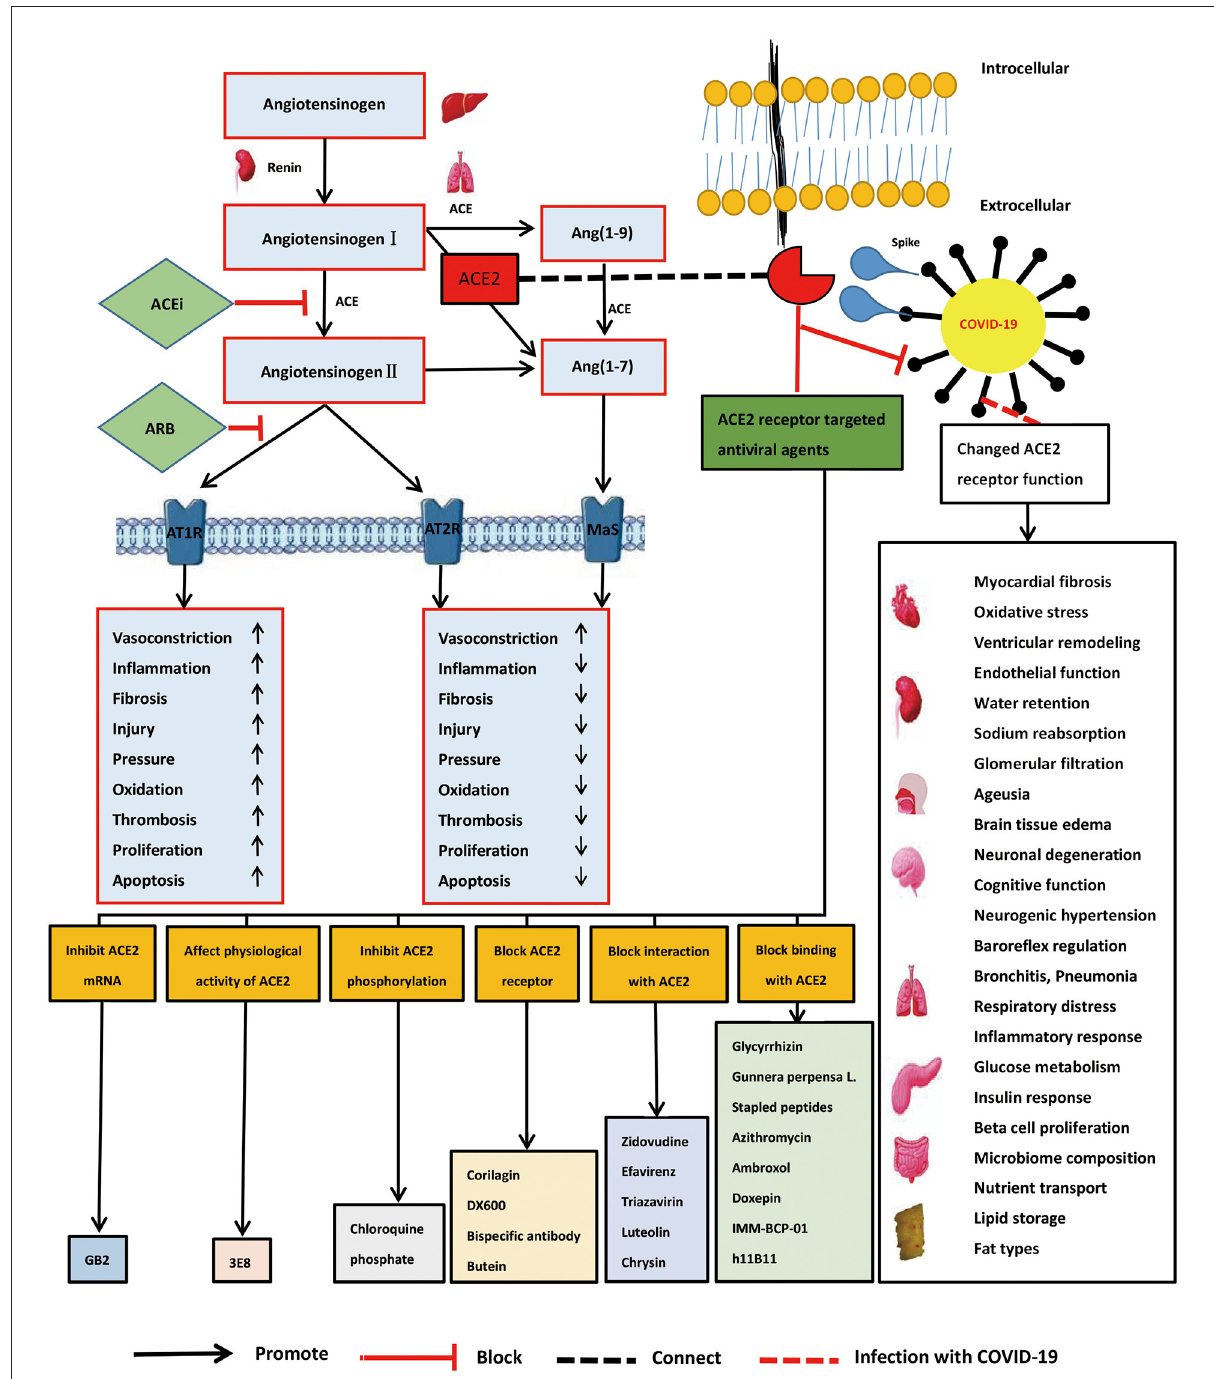
FIGURE1 Role of angiotensin converting enzyme 2 (ACE2) receptor, ACE2 mechanism of viral action, and development of ACE2-targeted strategies in severe acute respiratory syndrome coronavirus 2 (SARS-CoV-2) infection.